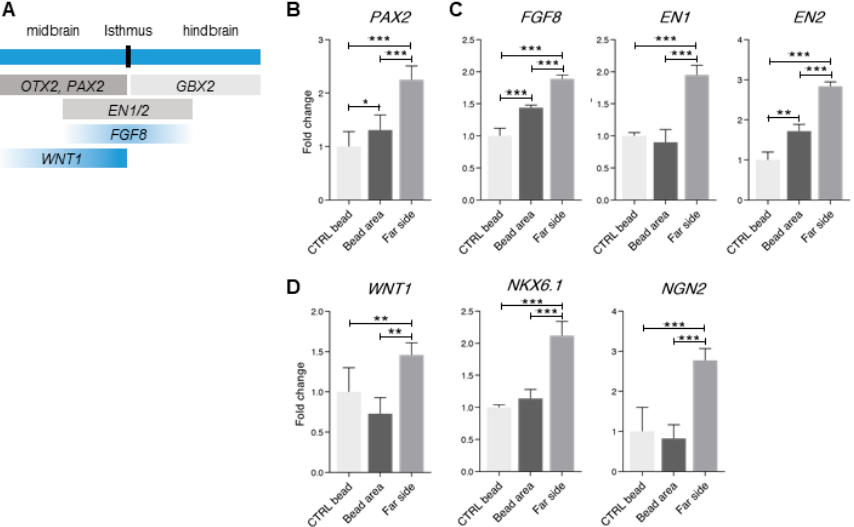
Figure 5. Emergence of isthmus-related genes in human brain organoids (4 × condition). ( A ) Schematic of the genes which are expressed during the development from the midbrain (anterior/rostral side) through the isthmus border and to the hindbrain (posterior/caudal side). ( B – D ) qPCR analysis of genes which are expressed in the bead area versus the far side of the organoid and compared to the controls. ( B ) Expression of the midbrain gene PAX2 . ( C ) Expression of the midbrain-hindbrain border genes FGF8 , EN1 and EN2 . ( D ) Expression of the ventral-related genes WNT1 , NKX6.1 and NGN2 . Error bars represent ± SEM. N = 24 organoids per experimental group. Comparisons were analyzed using ANOVA with post-hoc Tukey’s multiple comparisons test (DF = 15): n.s. non-significant p -value > 0.05, * p -value < 0.05, ** p -value < 0.01, *** p -value < 0.001.